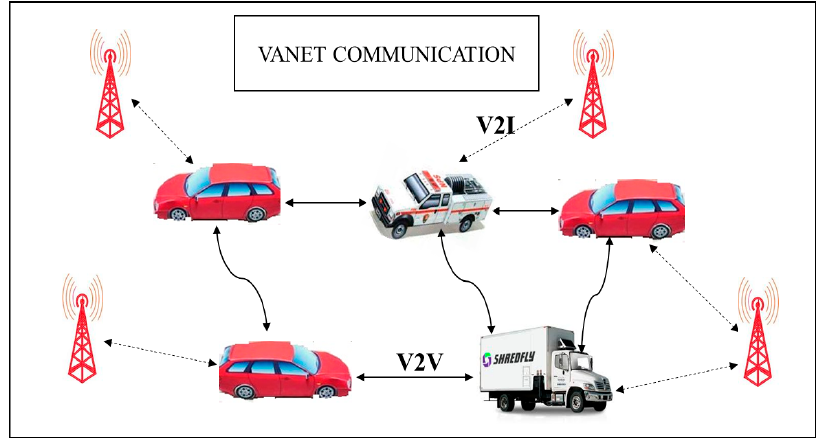
Figure 1. The architecture of vehicular ad-hoc network (VANET) communication.